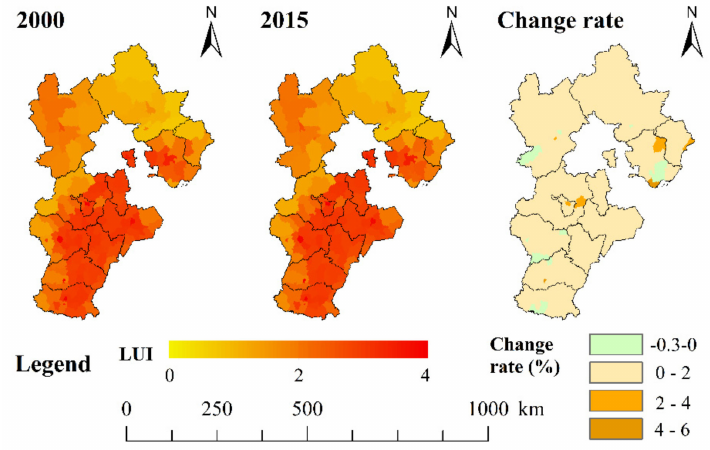
Figure 3. The land-use intensity of 2000 and 2015 and the change rate of LUI during 2000–2015 in